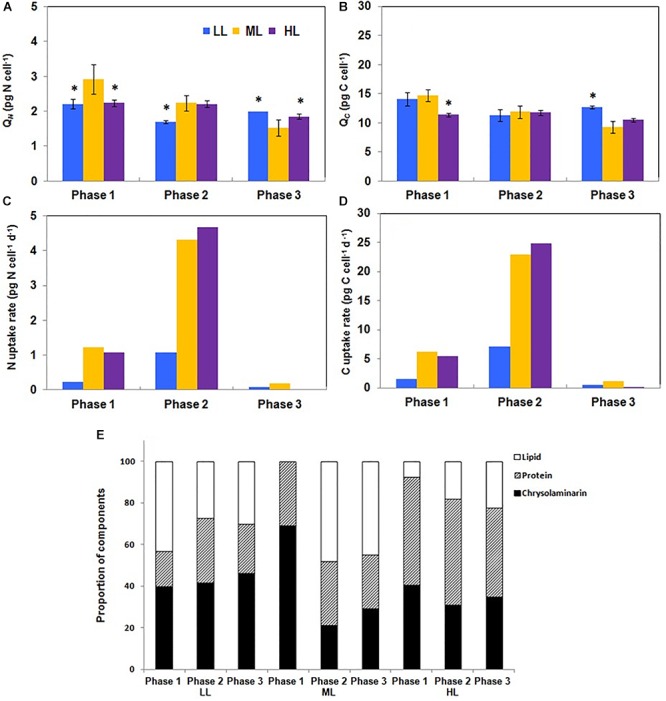
Modifications of the carbon, nitrogen, chrysolaminarin, protein and lipid content of Phaeodactylum tricornutum during growth under different photon flux densities. (A,B) The carbon and nitrogen cellular quota are not constant along growth. Under LL, QN, and QC decreased from phases 1 to 2 and increased from phases 2 to 3 whereas under ML, QN, and QC decreased continuously. Under HL, the decrease occurred only between phases 2 and 3. (C,D) The carbon and nitrogen uptake are maximum in phase 2. The rate of C and N uptake were the most intense in phase 2 and very reduced in phases 1 and 3. (E) The celluar quota in proteins, lipids and chrysolaminarin is impacted by the growth photon flux density. The relative amount of LPC was greatly impacted by the photon flux density. Lipids were the most abundant in phase 1 under LL whereas under ML and HL, they were barely detectable (E). Under LL, the relative abundance of lipids decreased during the transition from phases 1 to 2 and then remained constant until phase 3. This contrasts with ML and HL for which lipid proportion increased until phase 2 (ML) or phase 3 (HL). Data are mean values ± SE (n = 3) and error bars represent SD. Means followed by asterisks are significantly different from the corresponding value in ML (P ≤ 0.05, student’s t-test).